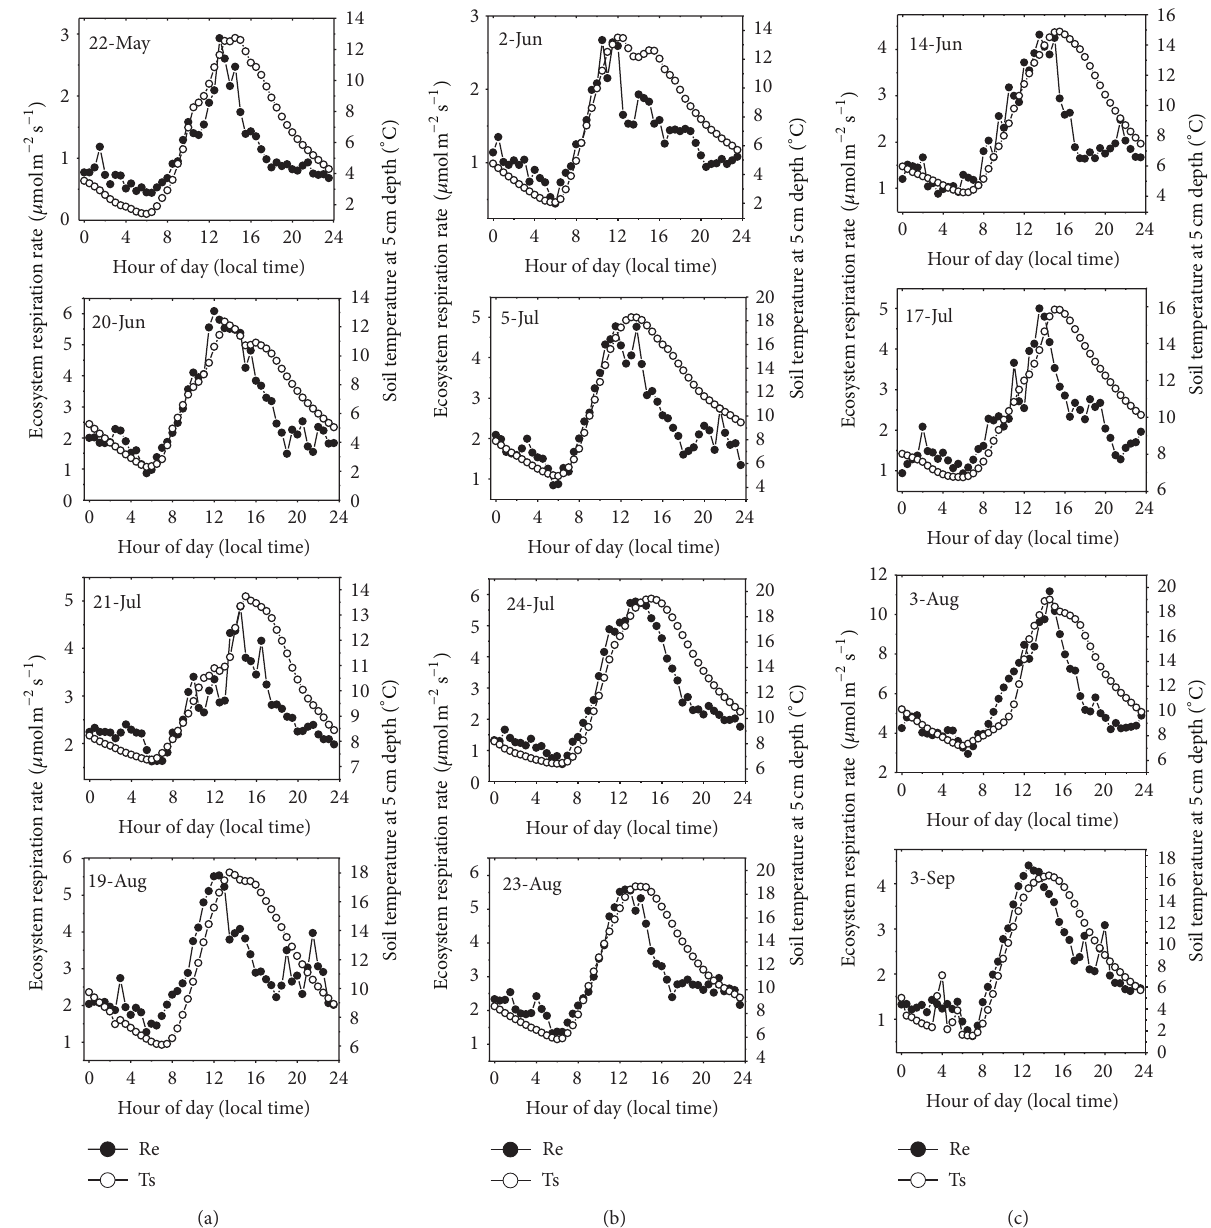
Figure 1: Diurnal variations of ecosystem respiration rate ( 𝜇 moLm −2 s −1 ) and soil temperature at 5 cm depth ( ∘ C) during the grown season from May to September.